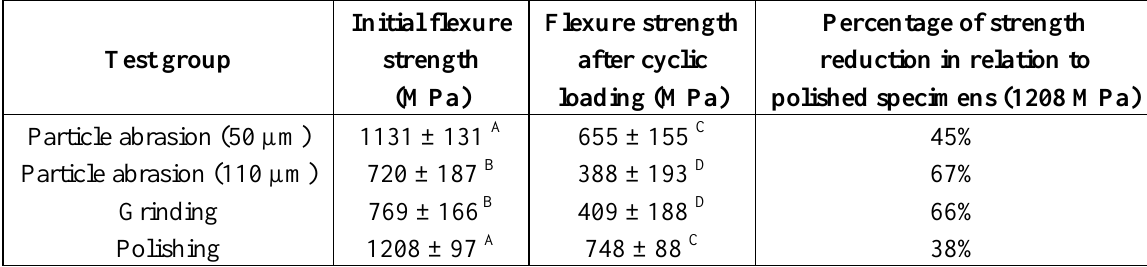
Table 1. Percent of reduction in flexure strength after cyclic loading compared to theoretical strength of polished group. Groups with similar capital superscript letters indicate no significant statistical difference in flexure strength at same test interval.